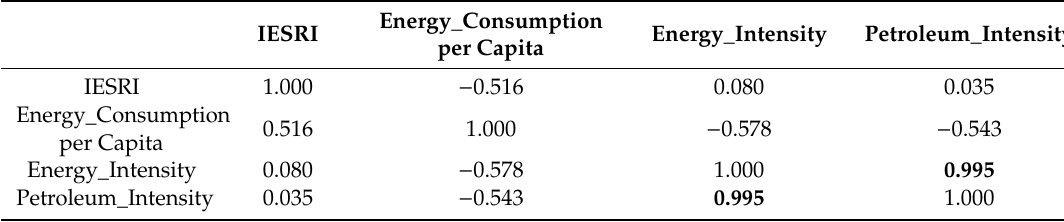
Table 13. Pearson Correlation parameters from the Energy Use Intensity